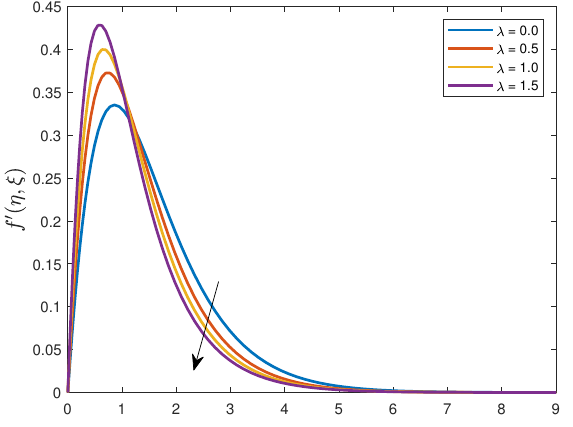
Figure 4. The influence of λ on fluid velocity.